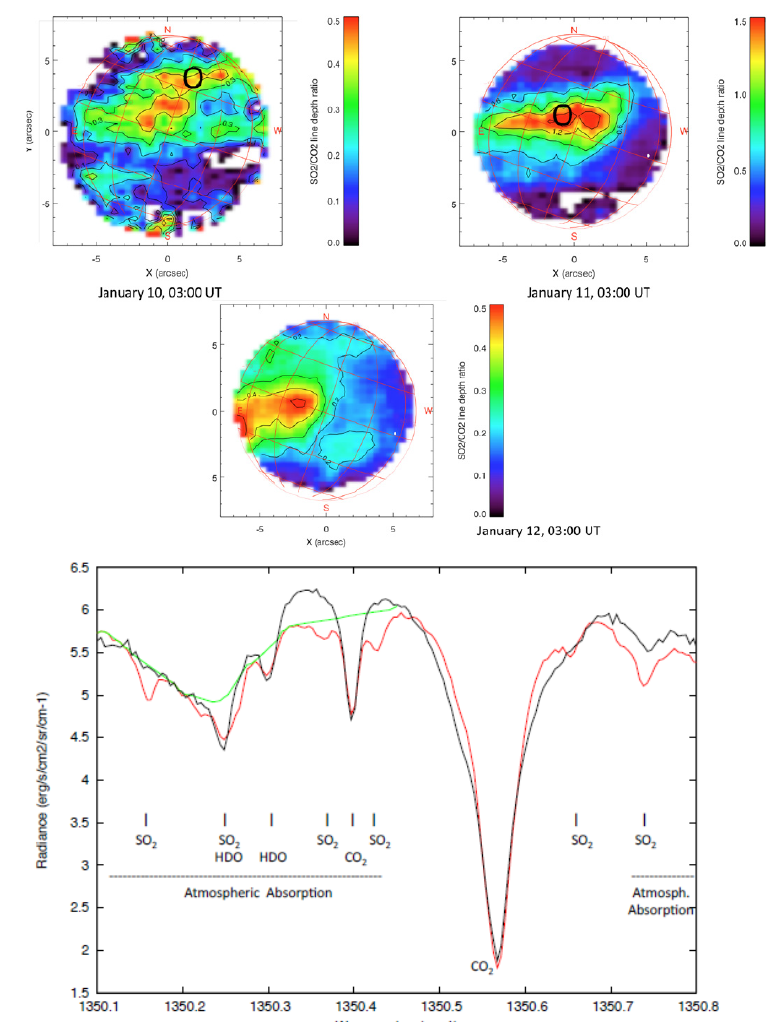
Figure 1. Mapping of SO 2 on Venus—Observations by TEXES. ( Top panel ) Map of the line depth ratio of SO 2 /CO 2 and its variability in time. From left to right: January 10; January 11; January 12 (2012). Values of the line depth ratio have a range of 0.0–0.5 for January 10 and 12; and 0.0–1.5 for January 11. The black circle indicates maximum SO 2 absorption. ( Bottom panel ) TEXES observations of Venus, at approximately 1350.1–1350.8 cm − 1 (7.4 µ m). Red: spectrum corresponding to an area of the disk with a maximum abundance of SO 2 . Black: spectrum corresponding to an area of the disk with a maximum of CO 2 . Green: modeled telluric absorption. (image credits: Encrenaz et al.